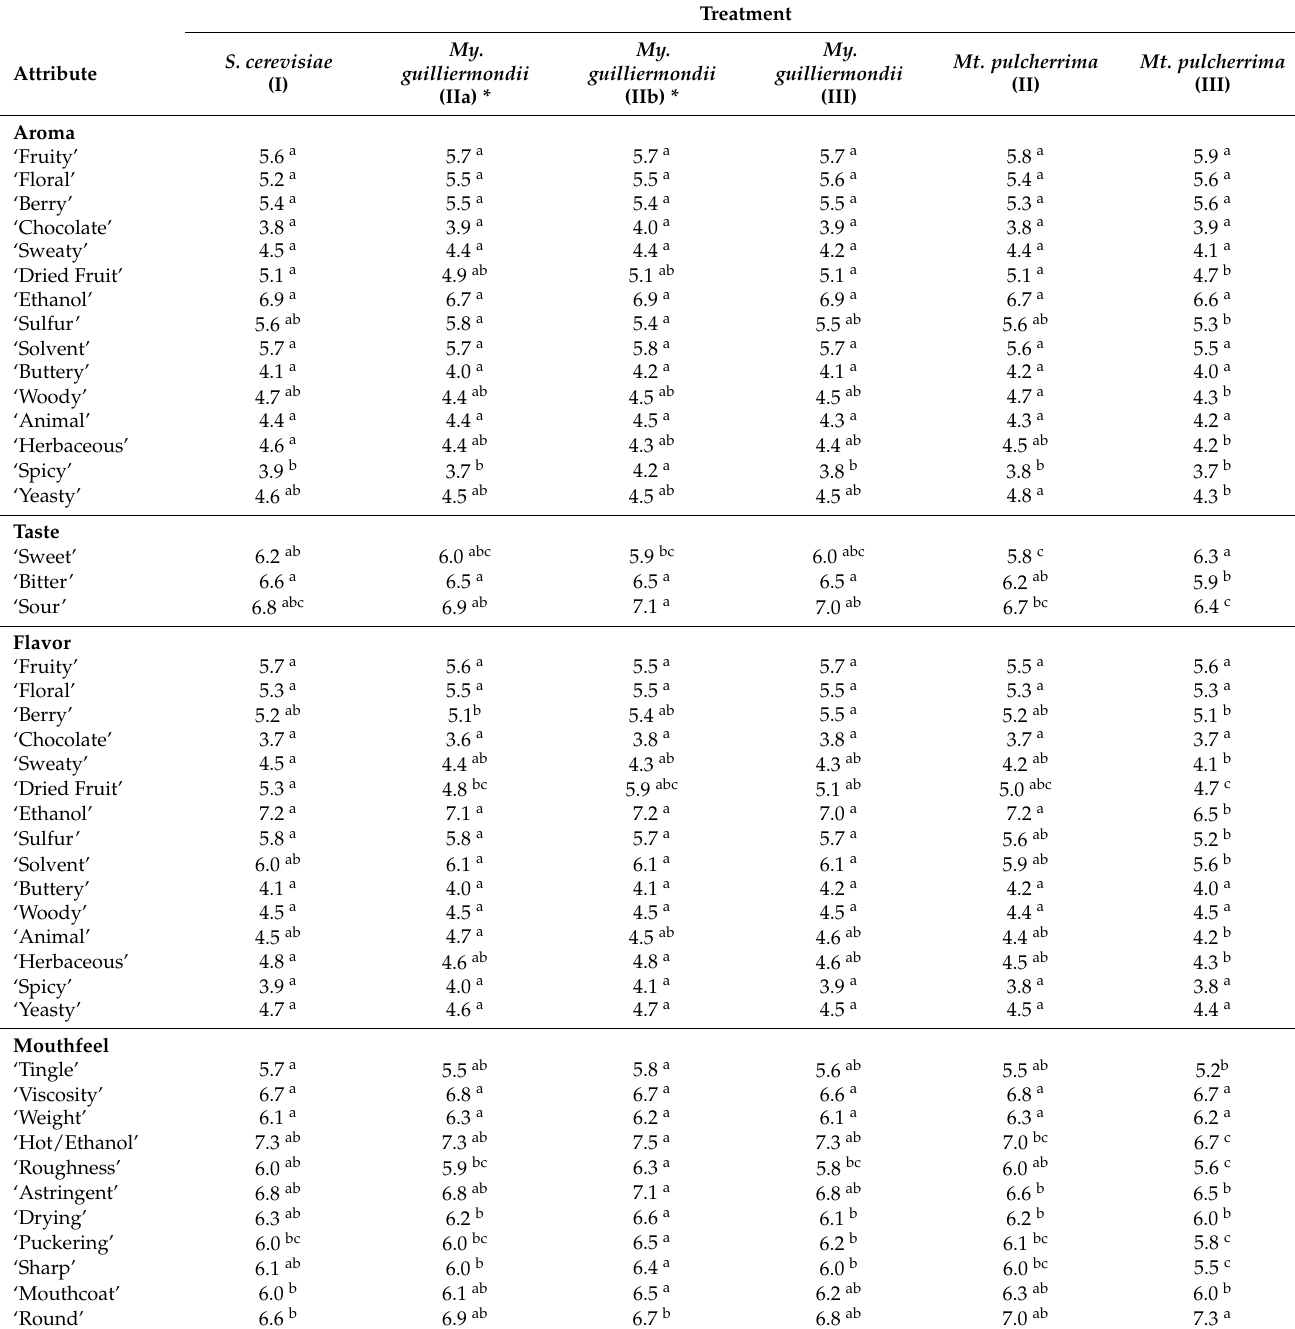
Table 3. Mean scores for sensory attributes of wines inoculated without or with different non- Saccharomyces yeasts following fermentation temperature regimes I, II, or